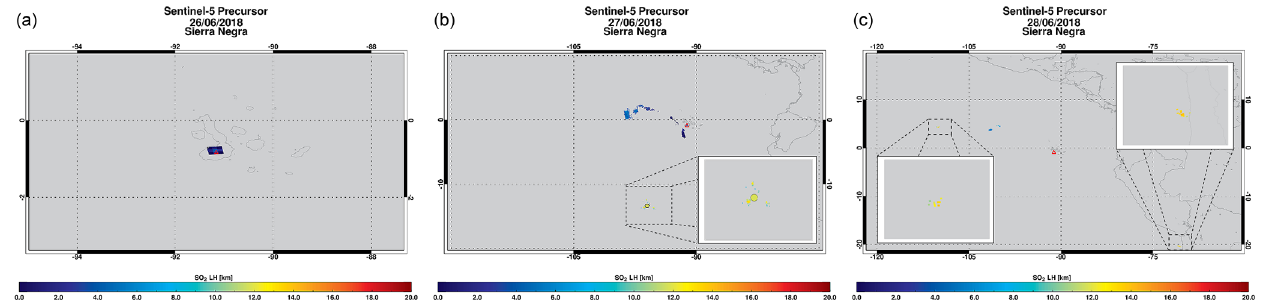
Figure 10. FP_ILM SO 2 LHs for the TROPOMI measurements shown in Fig. 9. Note that only pixels with SO 2 VCD values greater than or equal to 20DU are shown. The MLS SO 2 measurement of the volcanic plume on 27 June is indicated by a colored circle.